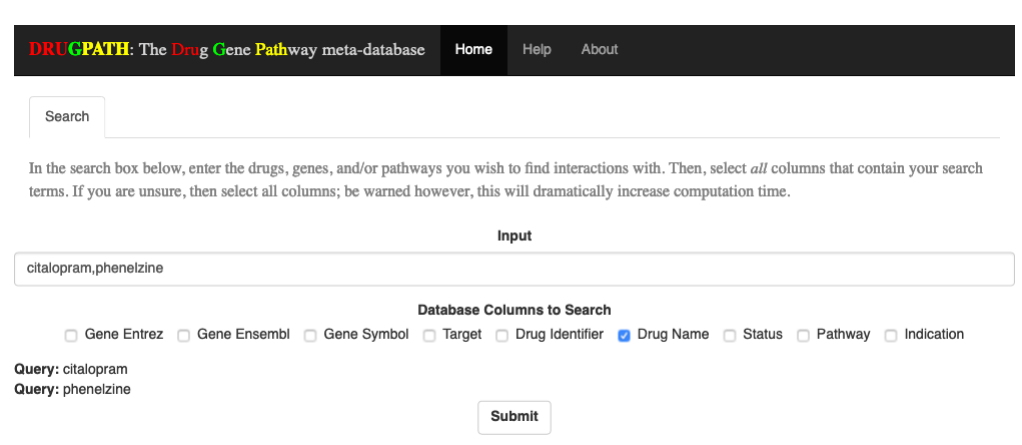
Figure 12. As the user inputs the search terms, they are shown at the bottom of the page.